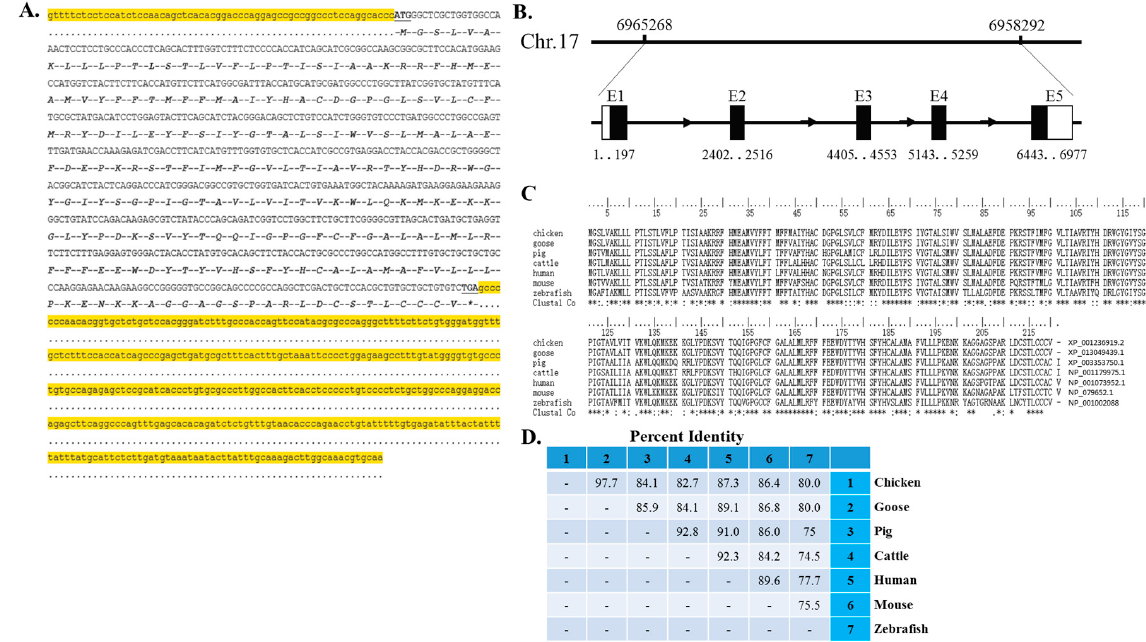
Figure 1. cDNA sequence, genomic structure and protein conservation of the chicken Myomaker gene. ( A ) The obtained cDNA sequence of chicken Myomaker transcripts. Nucleotides highlighted in yellow represent the 5 ʹ UTR and 3 ʹ UTR. Nucleotides in capital letters represent open reading frames, and letters below represent encoded amino acids. * represents stop codon; ( B ) Genomic structure of the chicken Myomaker gene. Black boxes indicate coding sequence regions, and white boxes indicate UTRs; ( C ) Amino acid alignment of Myomaker proteins from chicken, goose, pig, cattle, human, mouse and zebrafish. Conserved sequences are marked with asterisk within the line of Clustal Co.; ( D ) Percent identities of Myomaker amino acids compared to chicken, goose, pig, cattle, human, mouse and zebrafish Myomaker amino acids.